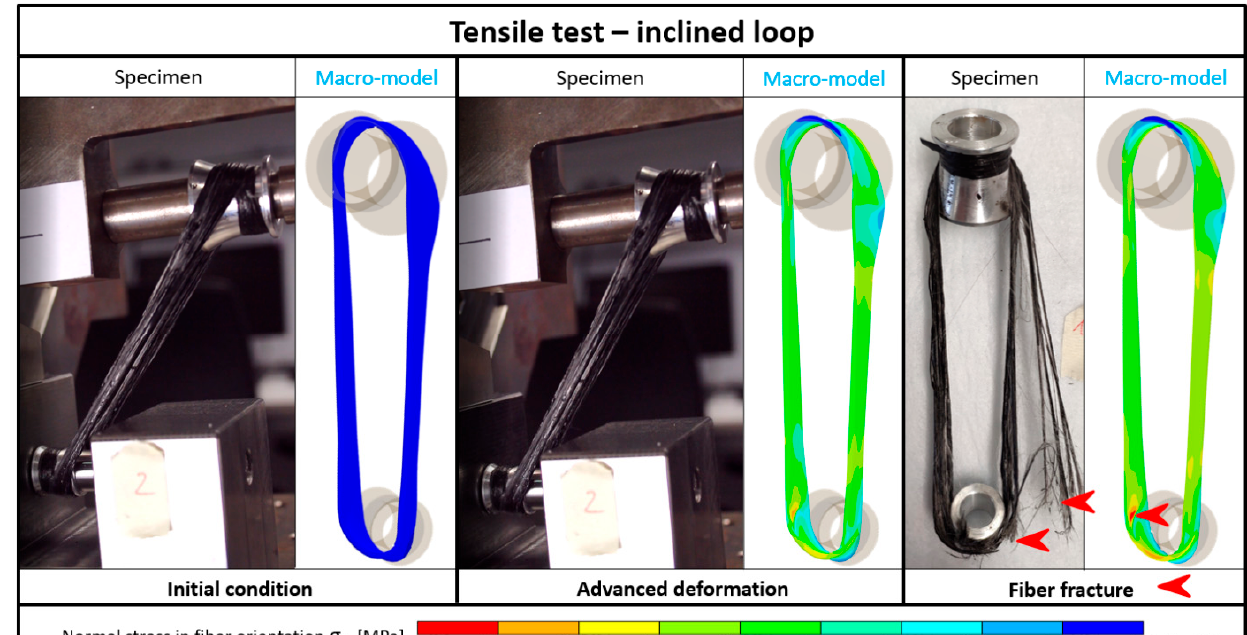
Figure 22. Deformation and failure behavior of inclined loops (specimens and model).